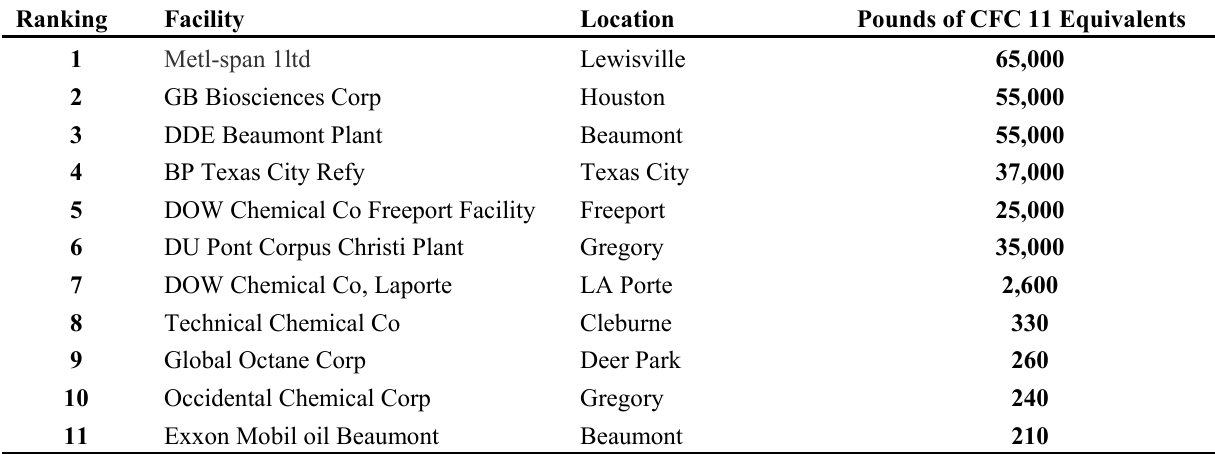
Table 8. Facilities Releasing Ozone Depleting Chemicals : Top Ranked Chemical Carbon Tetrachloride.